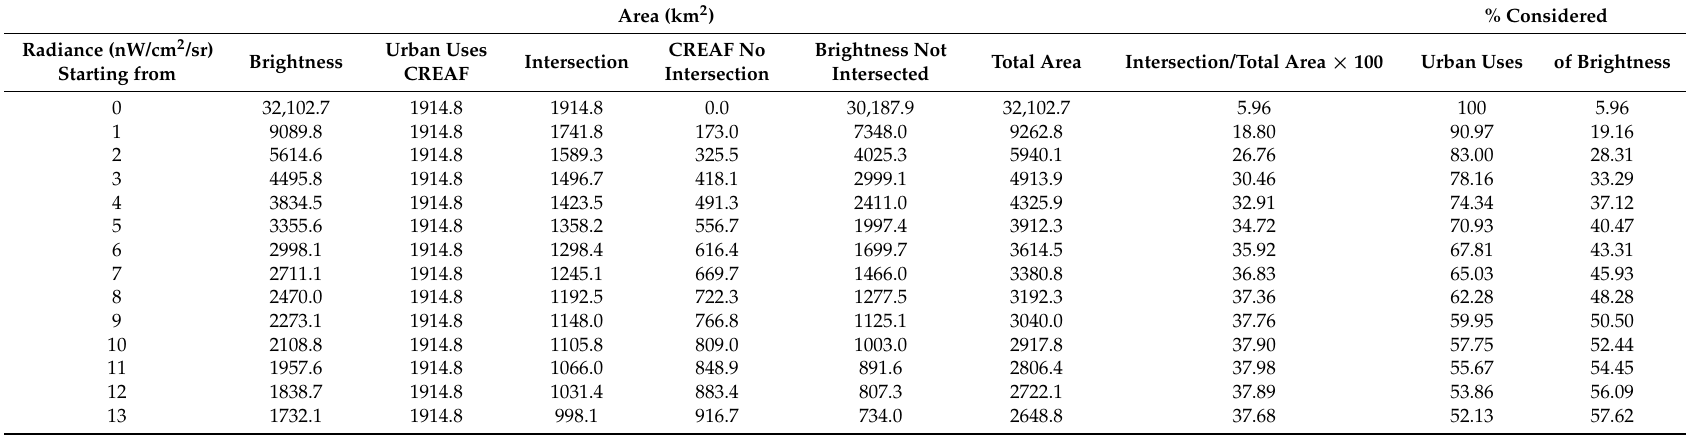
Table 2. Determination of the reference threshold between the luminosity and the urban land cover of CREAF (2009) for the whole of Catalonia. Area (km 2 ) % Considered Urban Uses CREAF No Brightness Not Radiance (nW/cm 2 /sr) Brightness Intersection Total Area Intersection/Total Area × 100 Urban Uses of Brightness CREAF Intersection Intersected Starting from 0 32,102.7